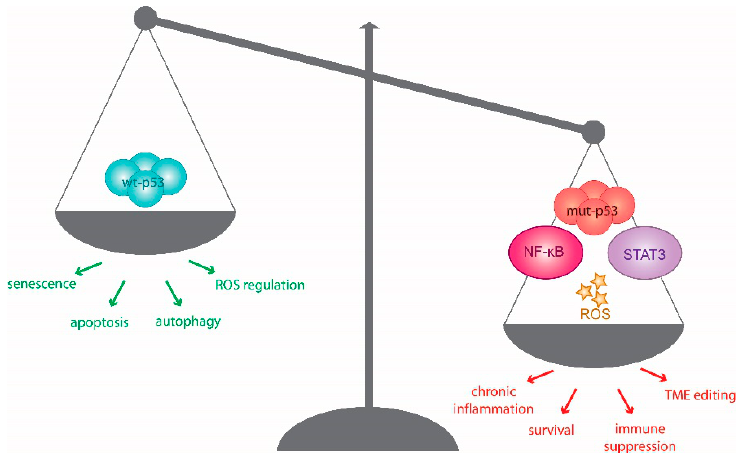
Figure 1. Mutant p53 feeds o ff and fuels inflammation. Wild-type p53 (Wt p53) contributes to e ff ective tumour immunity through its roles in senescence, apoptosis, autophagy and ROS regulation, as well as established roles in regulating immune response. Mutant p53 is able to subvert these e ff ects through dominant negative e ff ects and novel tumourigenic functions mediated through the inflammatory pathways of NF- κ B and signal transducer and activator of transcription 3 (STAT3). The excessive production of reactive oxygen species (ROS) can fuel inflammatory microenvironments without the regulation of wt p53, consequently feeding mutant p53 function and tipping the scales toward tumorigenesis. It is worth noting that innate immunity is not included in this model and is discussed later on.